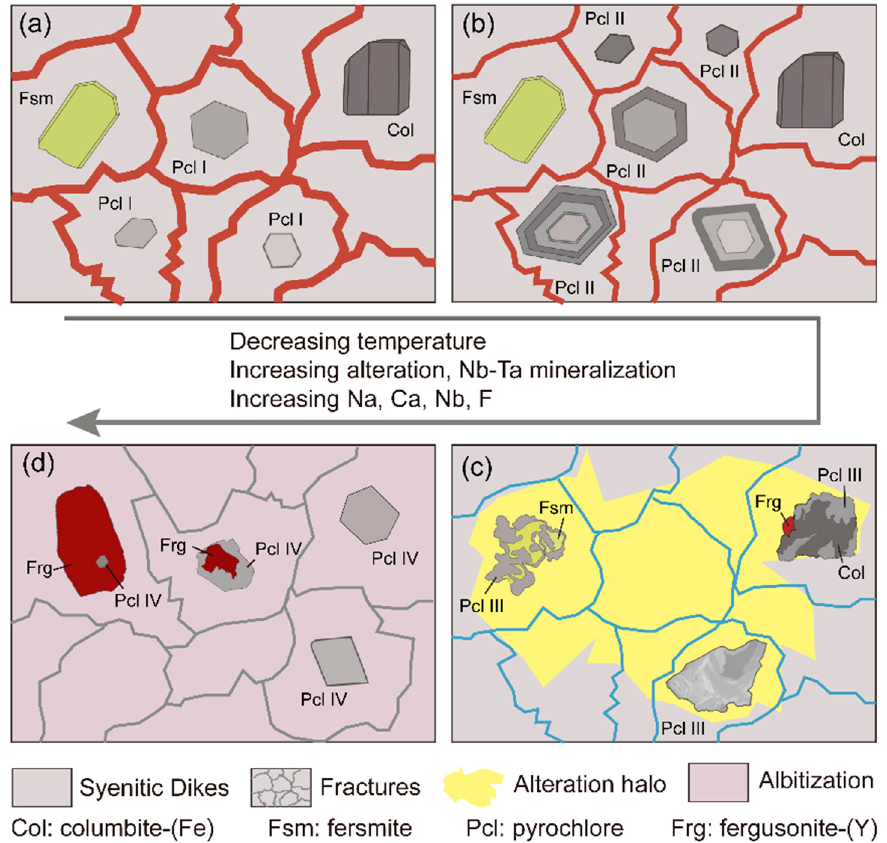
Figure 16. Schematic model of the formation and evolution of Nb–Ta minerals in the Huili Nb–Ta deposits. ( a ) Euhedral pyrochlore I, fersmite, and columbite-(Fe) crystals formed in the primary magma stage; ( b ) the magma gradually accumulated F, Nb, and Ca, resulting in pyrochlore II grew around the pyrochlore I and forming the rim; ( c ) the interaction of the earlier Nb–Ta minerals with magma-derived hydrothermal fluids with high contents of Na, Ca, and F in the late stage of the highly evolved magma; and ( d ) pyrochlore IV crystals associated with fergusonite-(Y) tend to be more concentrated in areas that underwent strong albitization. From ( a ) to ( d ), the Na, Ca, Nb, and F contents of ore-forming fluids increased and the temperatures decreased.